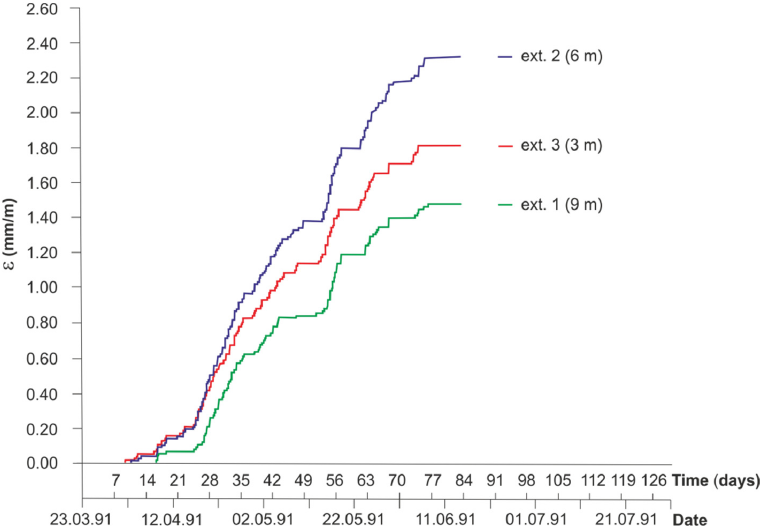
Figure 1. The accumulation of horizontal strain that was recorded from 29 March 1991 to 14 June 1991 using three extensometers installed at Station 2 Fahrradweg at Kapellen (own study). 2, the standard deviation of any single value 𝜀(𝑡) can be determined according to Equa-